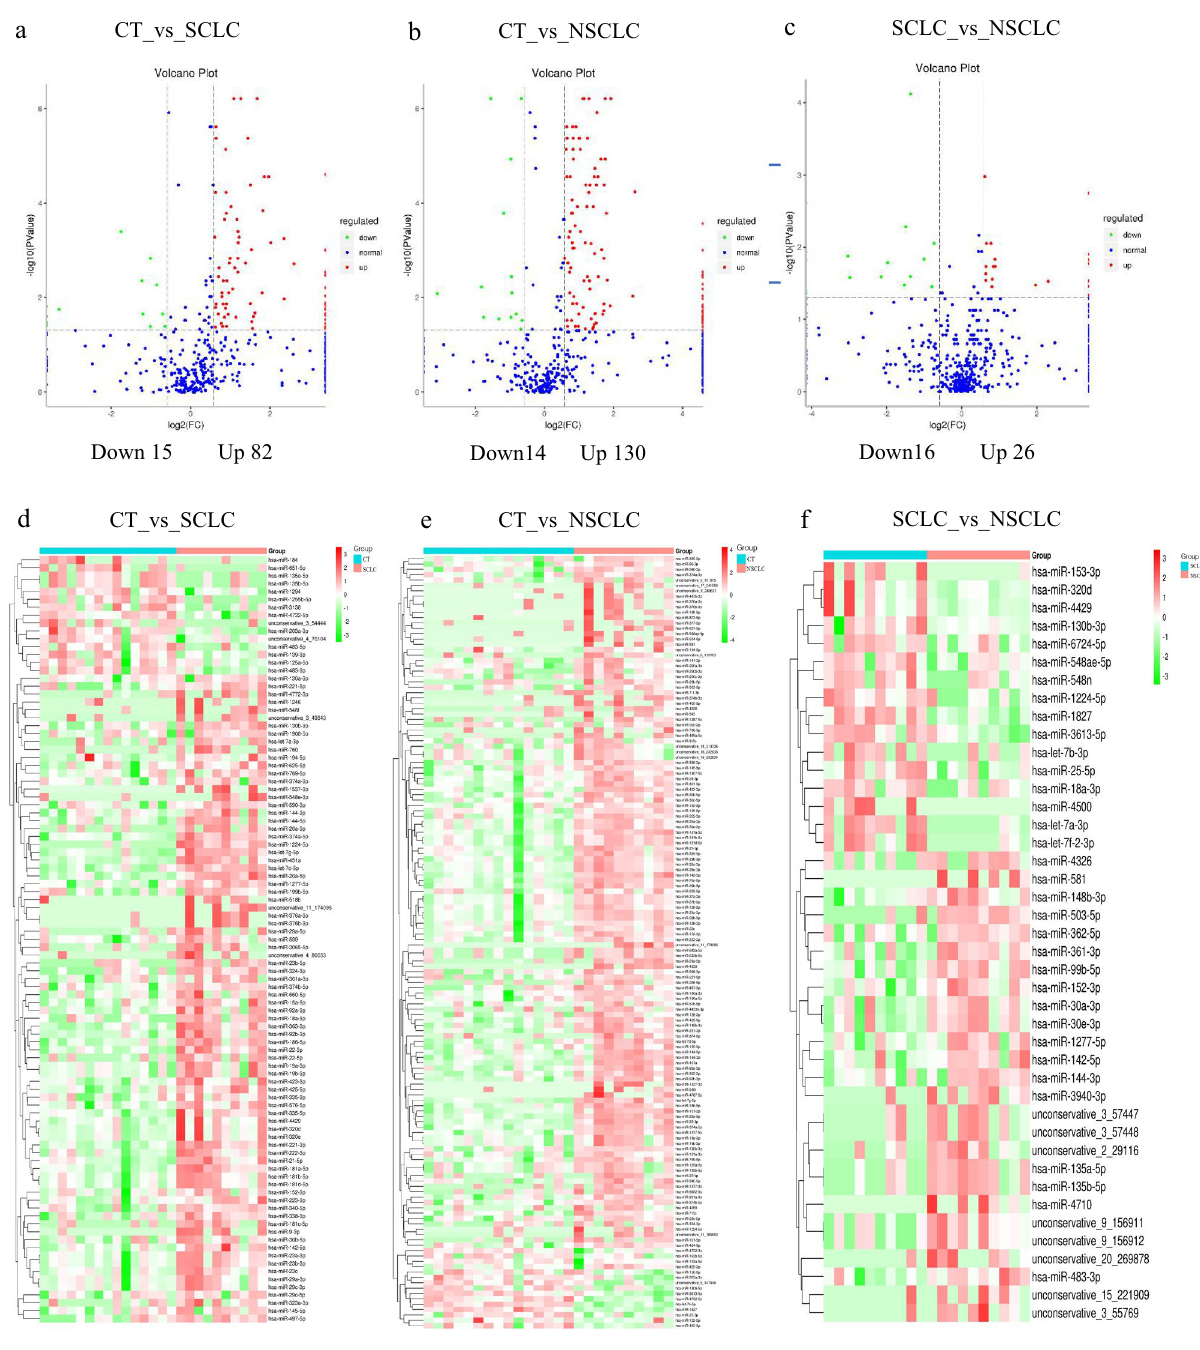
Figure 3. Identification and functional enrichment analysis of differentially expressed sEV-derived miRNAs. Volcano plot of differentially expressed sEV-derived miRNAs in CT versus SCLC, CT versus NSCLC and SCLS versus NSCLC ( a –c). Each point represents an miRNA, red represents upregulated miRNA, green represents downregulated miRNA, and blue represents non-differentially expressed miRNAs. Heatmap of differentially expressed sEV miRNAs in CT versus SCLC, CT versus NSCLC and SCLS versus NSCLC ( d – f ). Red indicates high relative expression, and green indicates low relative